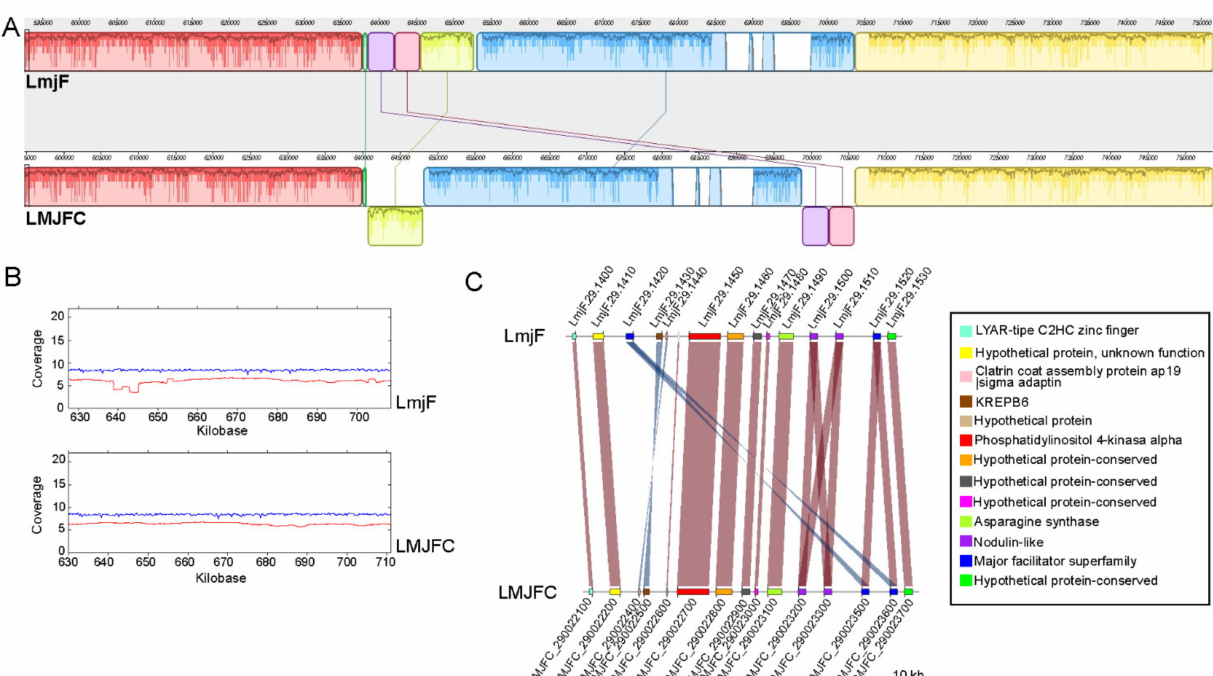
Figure 5. Reorganization of a region in chromosome 29 according to the LMJFC assembly regarding the reference LmjF genome. ( A ) Synteny blocks (represented by different colors that identified the conserved genomic regions) determined by pairwise comparisons between the LmjF genome (upper scheme) and the newly assembled LMJFC genome (bottom scheme), using the MAUVE tool. Blocks located underneath the X -axis denote inversion events. ( B ) The upper and bottom graphs show the coverages (log 2 ) of Illumina reads (in blue) and PacBio reads (in red) mapped to this chromosomal region in the LmjF and LMJFC assemblies, respectively. ( C ) Schemes show the reorganization at per gene level. Genes with sequence identity and identical orientation are colored in brown, whereas blue hues were used to denote an inverted orientation between the LmjF and LMJFC